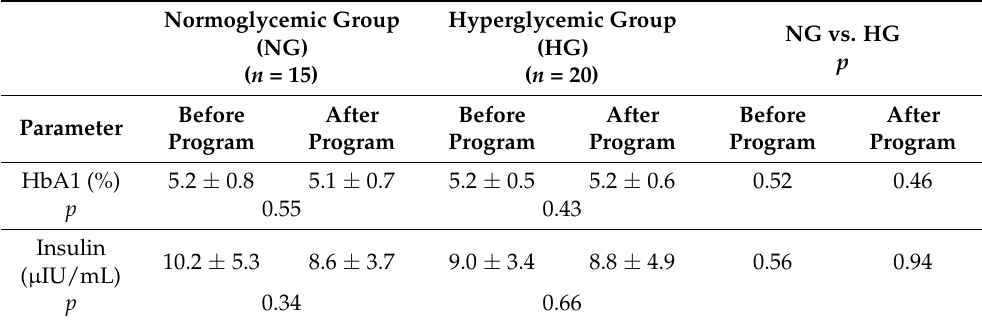
Table 3. Impact of the weight reduction program on glycated hemoglobin (HbA1c) and insulin levels in obese normoglycemic and hyperglycemic women.